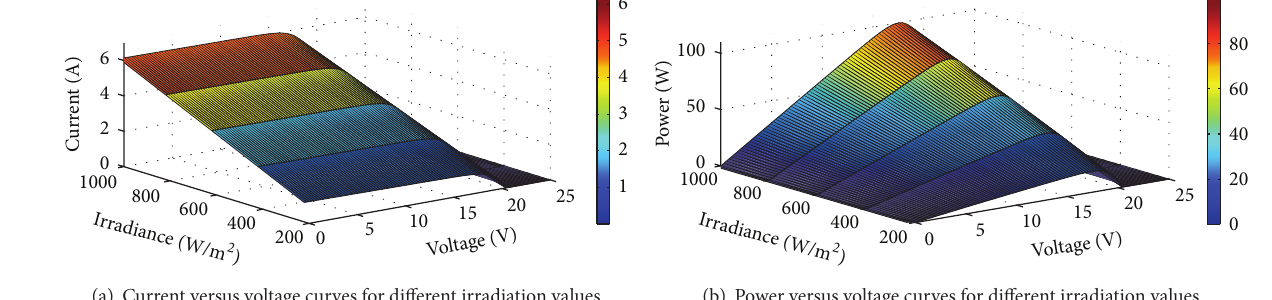
Figure 3: Parametric simulations of the ZDNY-100C36 series PV module.